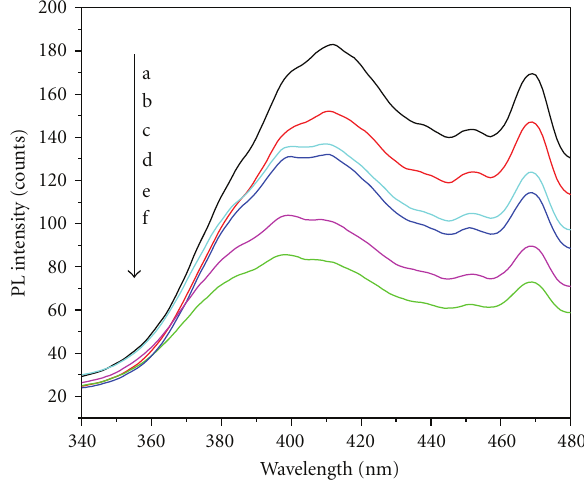
Figure 5: Photoluminescence emission spectra of photocatalysts. (a) TiO 2 , (b) CuO (0.1wt.%)/F-TiO 2 , (c) CuO (0.3wt.%)/F-TiO 2 , (d) CuO (0.5 wt.%)/F-TiO 2 , (e) CuO (3wt.%)/F-TiO 2 , (f) CuO (1wt.%)/F-TiO 2